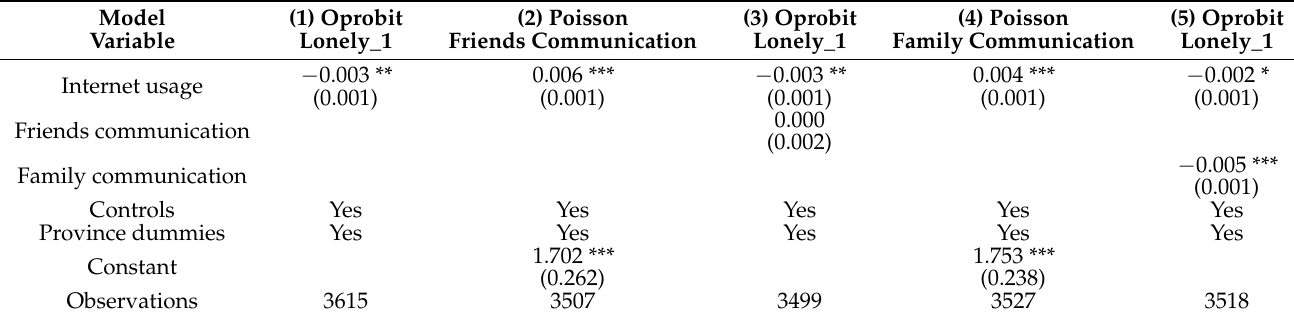
Table 7. Further impacts on loneliness.